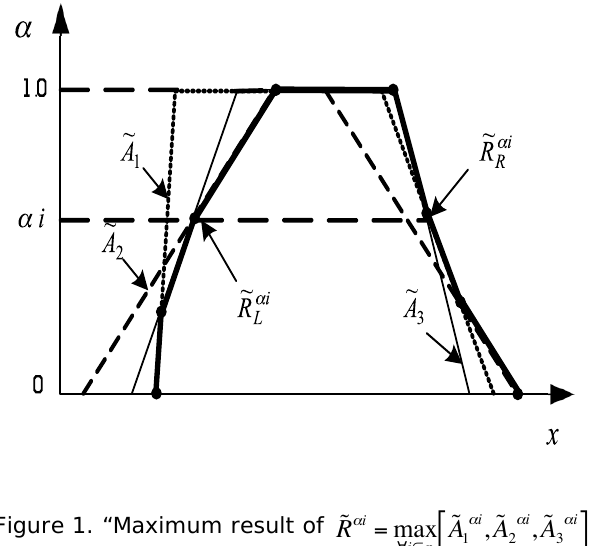
Figure 1. “Maximum result of ˜ R (cid:2) i = max